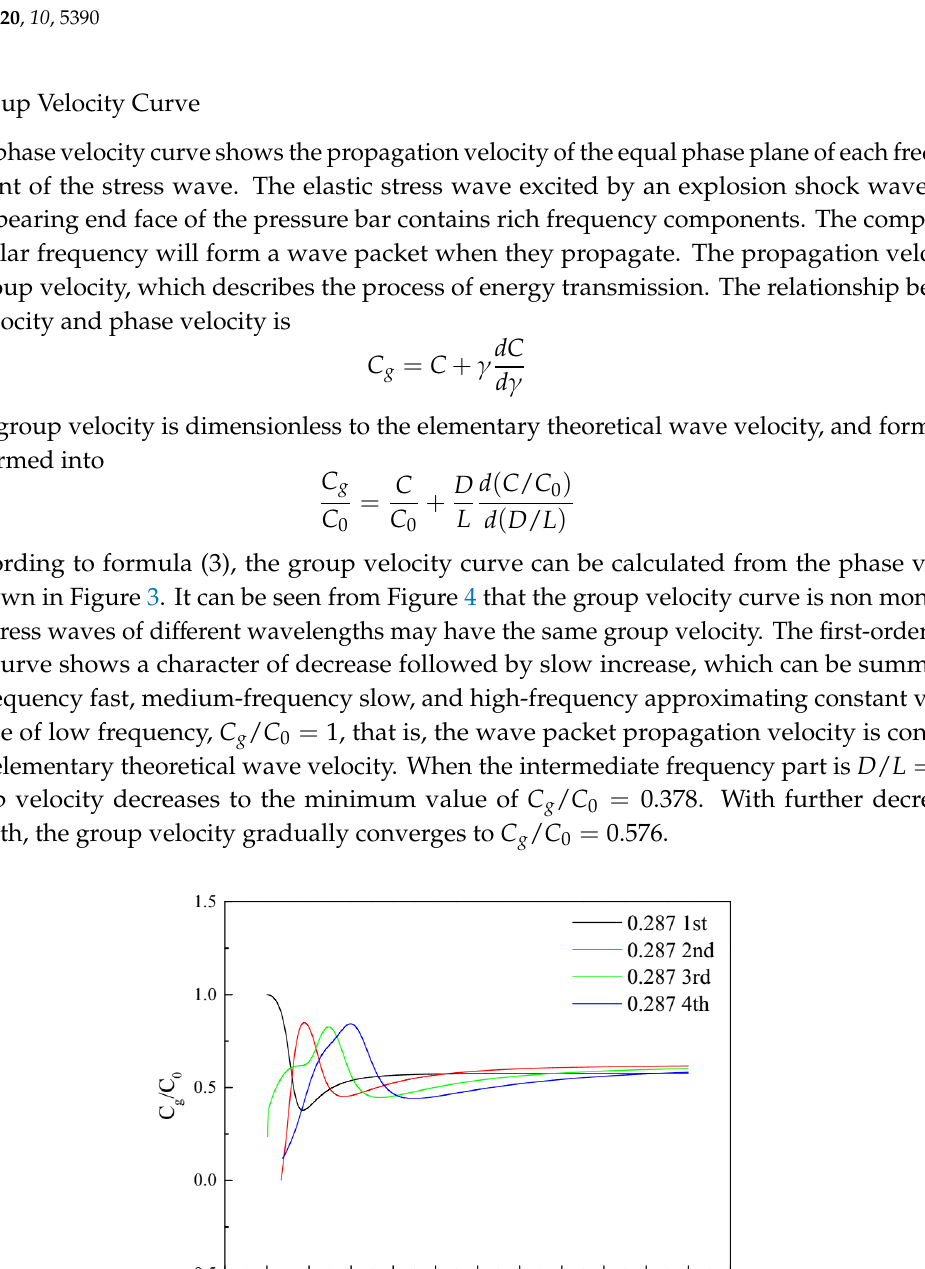
Table 2. Summary of peak, valley, and asymptotic values of the first to fourth order group velocity curves of Poisson’s ratio of 0.287 .